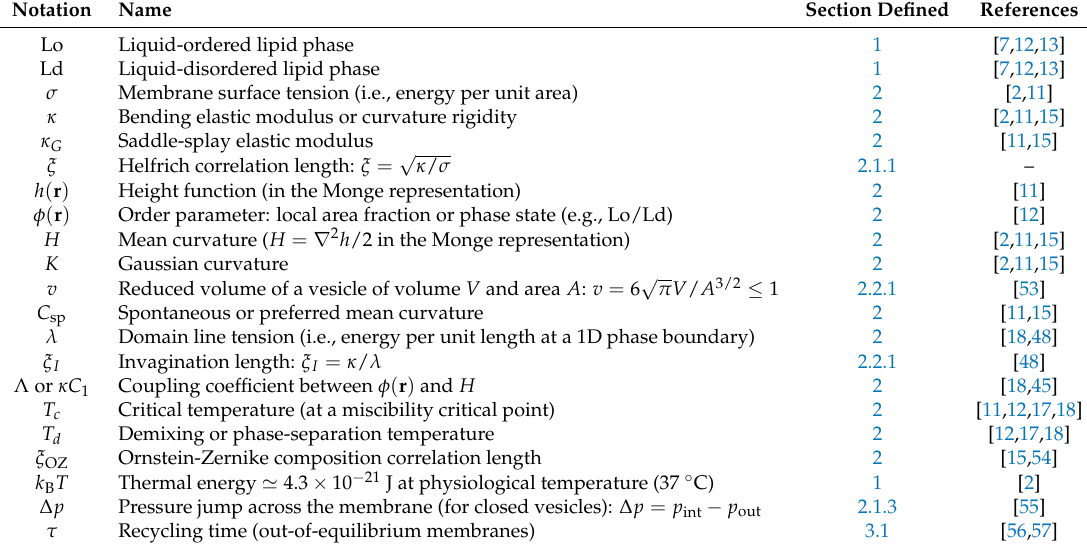
Table 1. Main notations used in this review, together with the sections where they are defined and useful